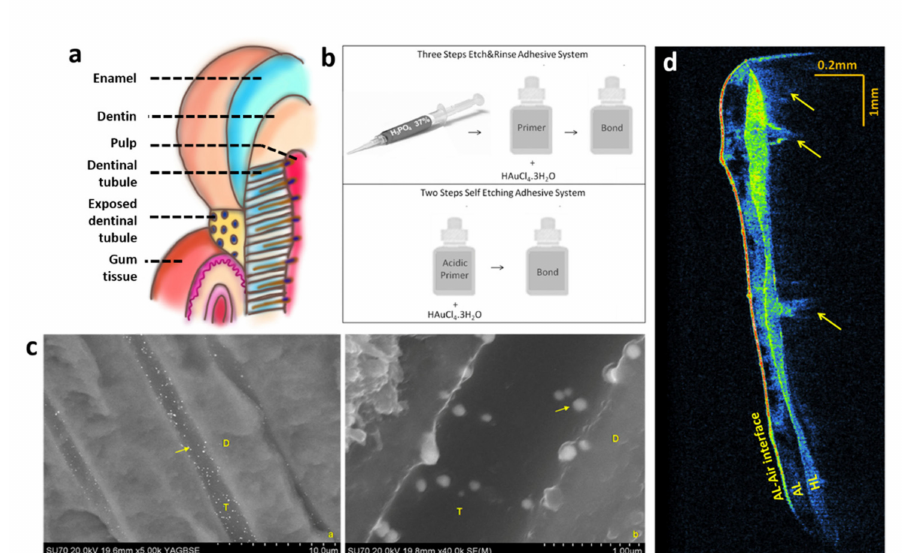
Figure 6. ( a ) Artistic rendering of dentinal tubules and its connection to the pulp; ( b ) Steps for the in situ gold nanoparticle preparation; ( c ) SEM images of dentinal tubules, showing the gold NP; ( d ) OCT image of the dentinal tubules, only possible due to the presence of gold NPs. Figures ( b – d ) reprinted with permission from